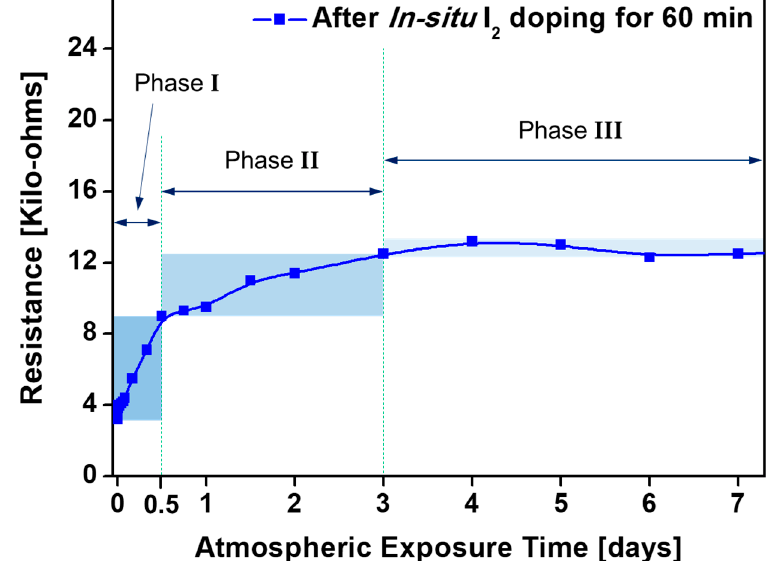
Figure 7. Changes in electrical resistance of in-situ I 2 -doped PANI film on IDE substrate.